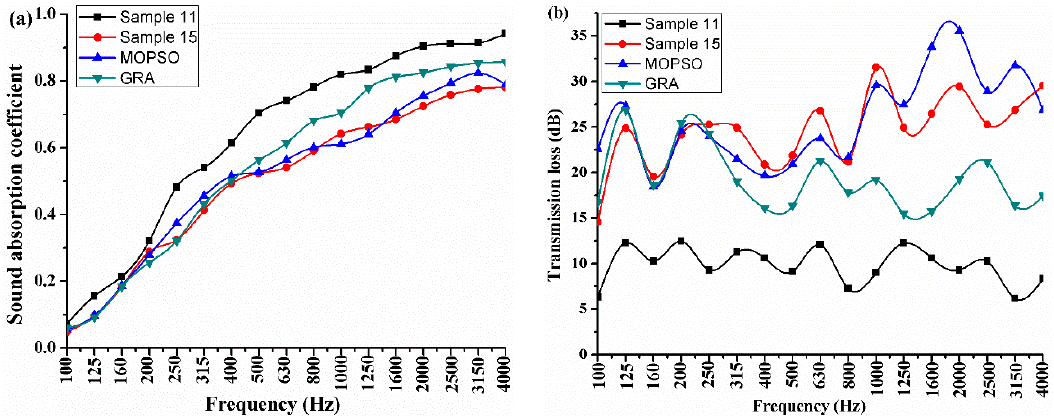
Figure 3. Acoustic performances curve of the PU foam composites ( a ) Sound absorption coefficient curves; and, ( b ) Transmission loss curves.